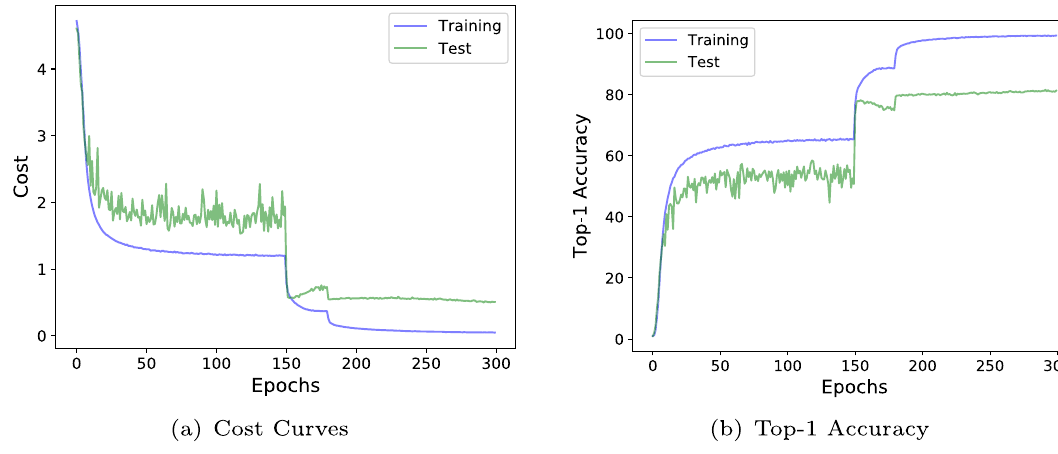
Fig. 3 Curves of the convergence cost and the accuracy, both of them are trained by the Cifar100 dataset